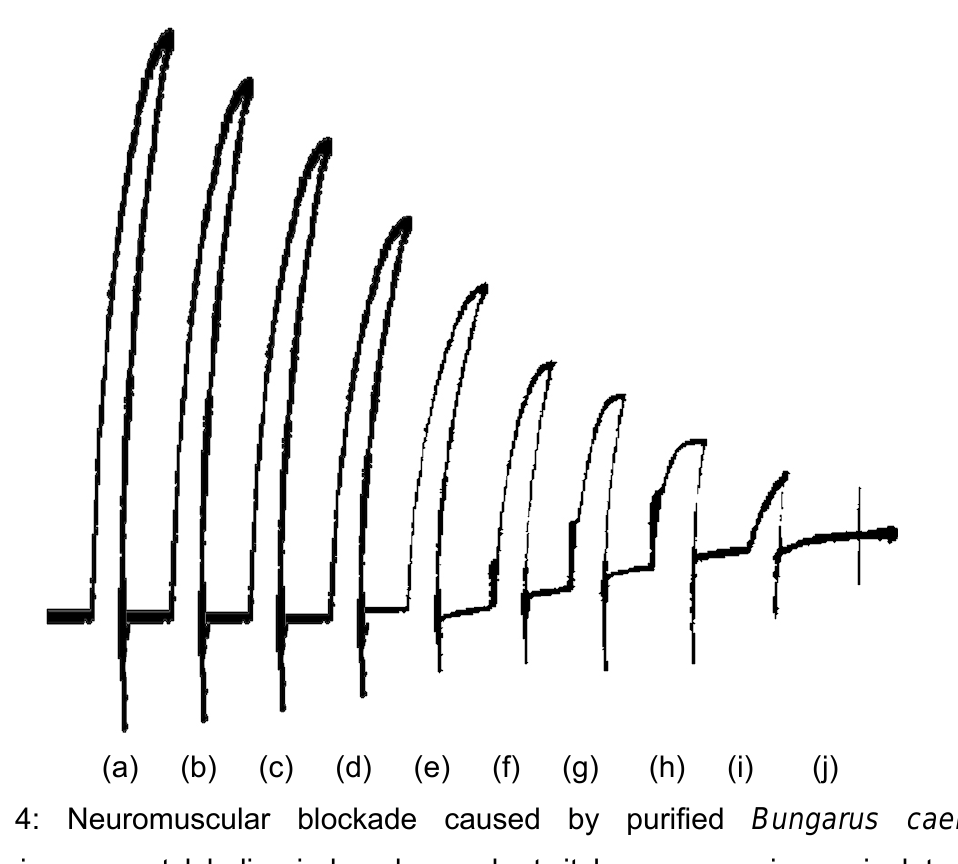
Neuromuscular blockade caused by purified Bungarus caeruleus neurotoxin on acetylcholine-induced muscle twitch response in an isolated frog rectus abdominis muscle preparation at different concentrations: (a) = 25µg; (b) = 50µg; (c) = 75µg; (d) = 100µg; (e) = 125µg; (f) = 150µg; (g) = 175µg; (h) = 200µg; (i) = 225µg; (j) = 225µg + 100µg